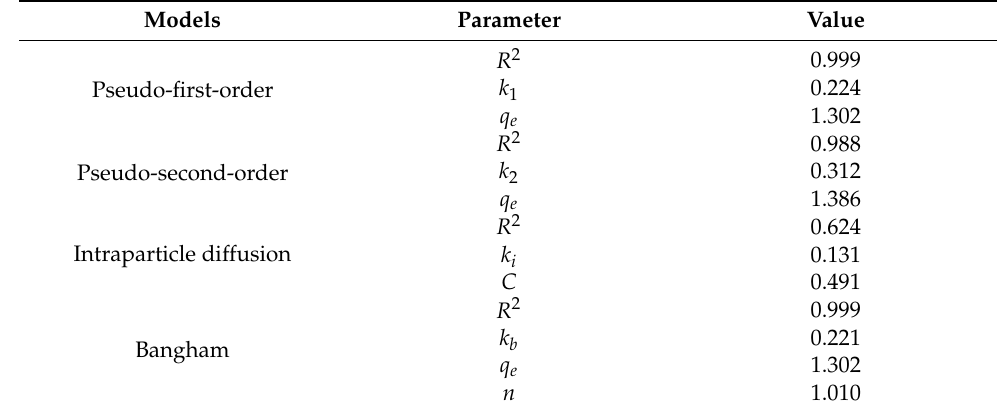
Table 4. Kinetics parameters for magnesite modified by [APMIM]Br under the conditions of 50 ◦ C, 0.4 MPa and gas flow rate 150